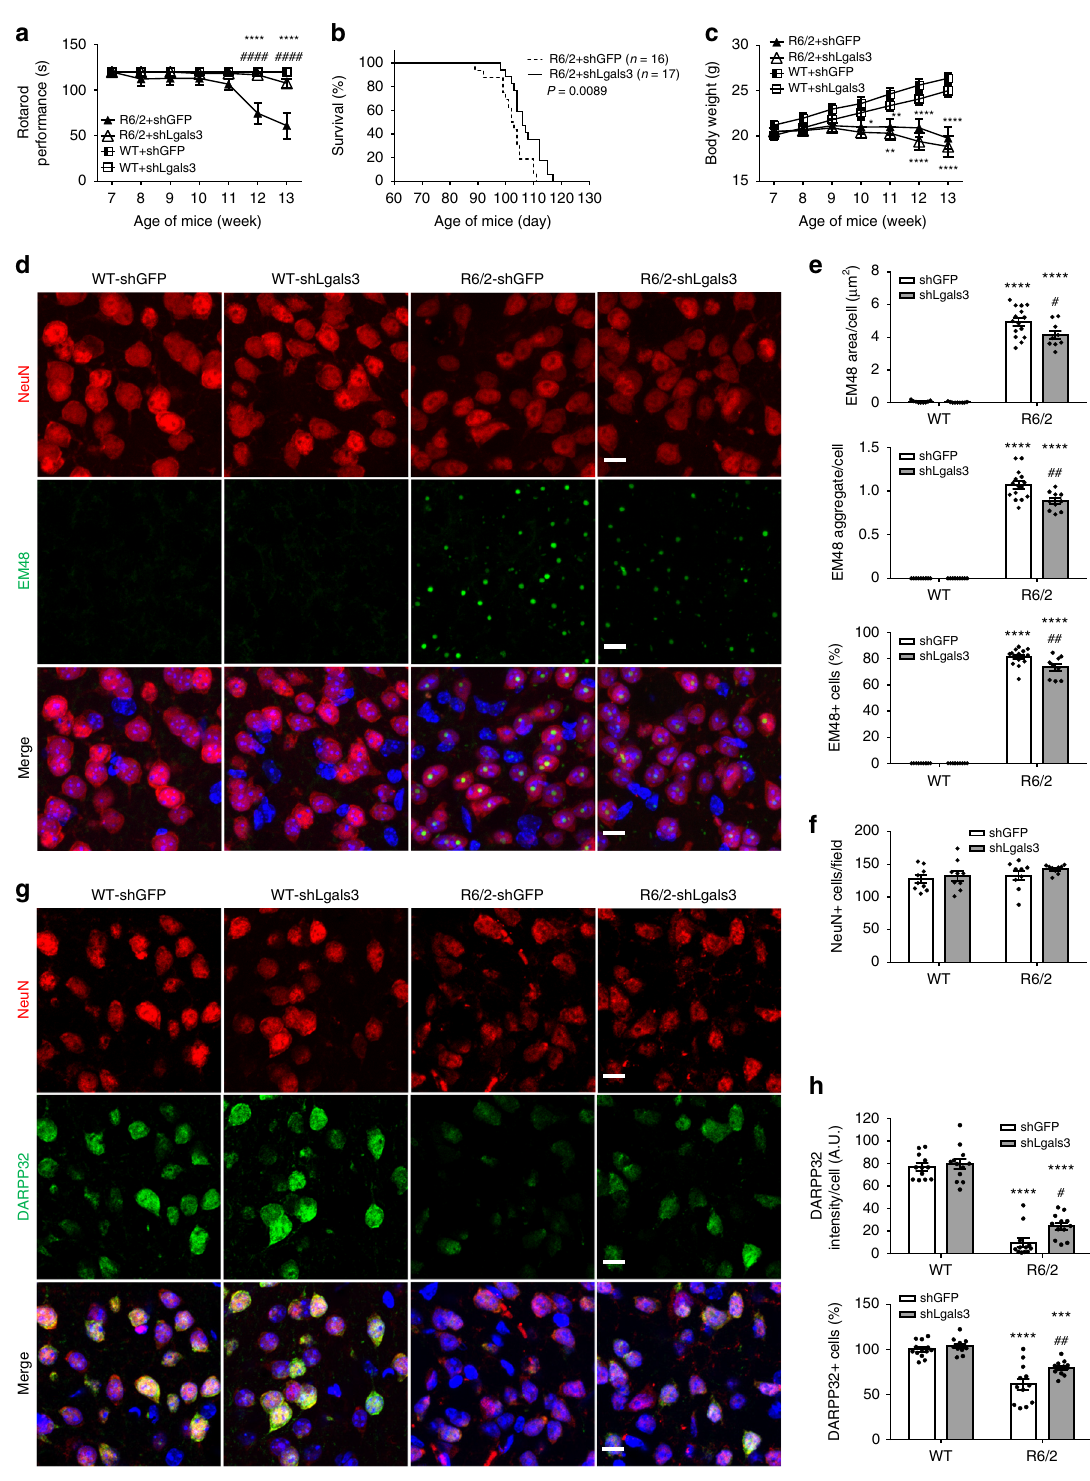
Fig. 9 Knockdown of Gal3 ameliorates HD symptoms in R6/2 mice. Mice of 6 weeks were intrastriatally injected with the sh Lgals3 -expressing or shGFP - expressing lentivirus, and monitored for an additional 7 weeks ( n = 9 – 11 mice in each group). a The motor functions of R6/2 mice and their littermate controls were assessed by rotarod performance. b Kaplan – Meier plots of R6/2 and WT mice ( P = 0.0089). c Body weight of the indicated animal was measured from 7 to 13 weeks of age. Brain tissues were carefully removed and subjected to immuno fl uorescence staining to determine the amount of mHTT aggregates (green, EM48; d , e ) or DARPP32 (green, a marker for the medium spiny neurons (MSNs), g , h ), on the neurons (NeuN, red; a neuronal marker; d , f , g ). Nuclei were stained with Hoechst (blue). Four animals were analyzed in each group. The results were analyzed by two-way ANOVA followed by Tukey ’ s post hoc test. Data are presented as the means ± SEM. *Speci fi c comparison between WT and R6/2 mice infected with the same lentivirus; #Speci fi c comparison between mice of the same genotype. * P < 0.05, ** P < 0.01, *** P < 0.001, **** P < 0.0001. Same P -value denotation for #. Scale bar: 10 µ m. Source data is available as a Source Data